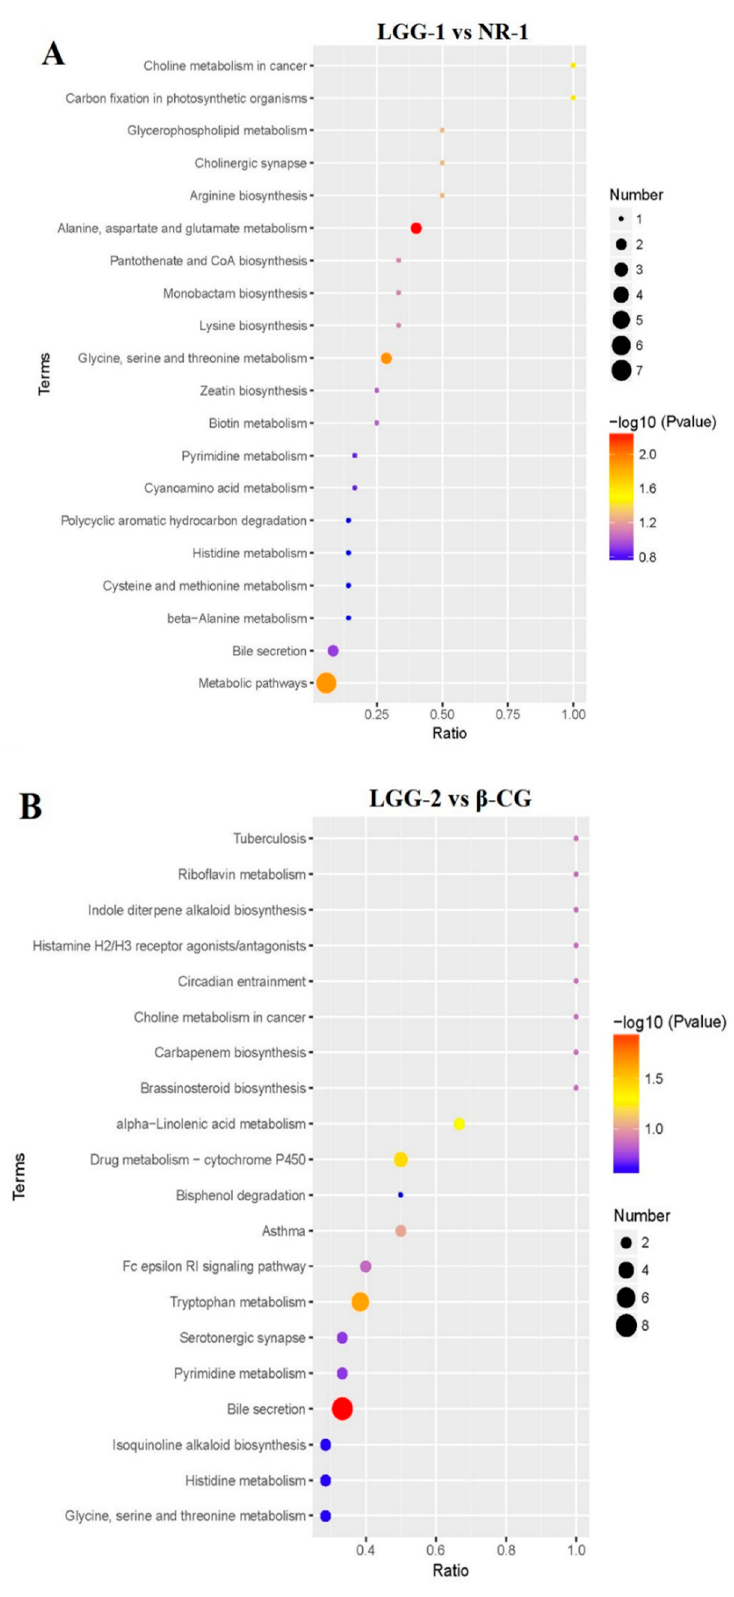
Figure 6. Comparing the bubble chart of the enriched KEGG pathway between different groups. ( A ) Metabolomic pathway chart in positive ion mode between the LGG-1 group and the NR-1 group; ( B ) Metabolomic pathway chart in positive ion mode between the LGG-2 group and the β -CG group.